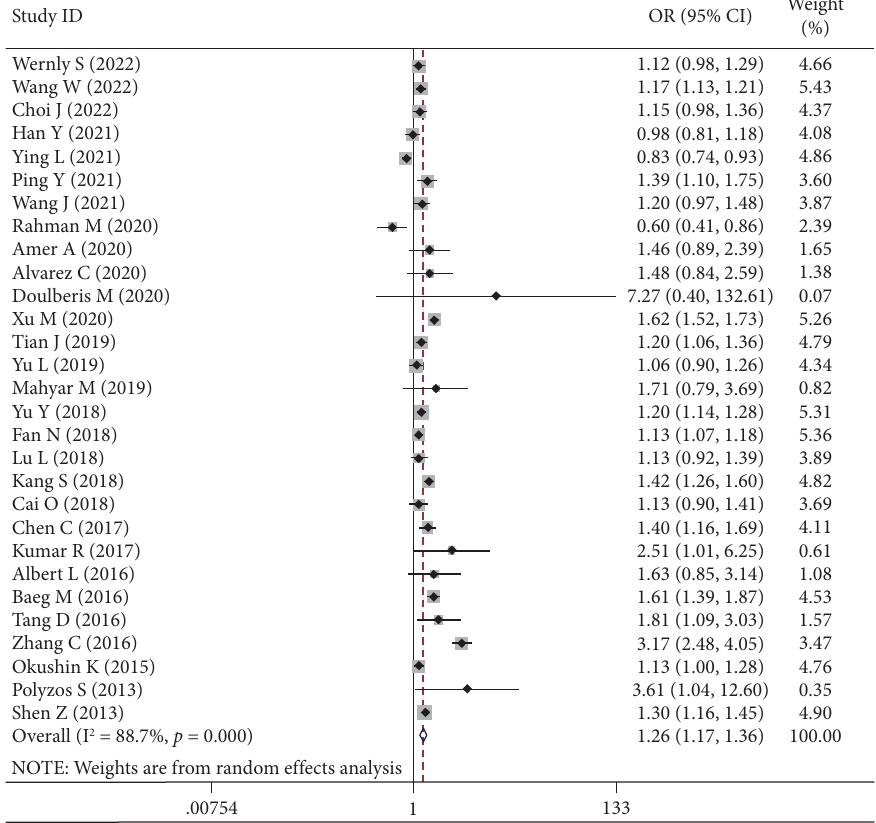
Figure 2: Forest plots for unadjusted data from cross-sectional studies and case-control